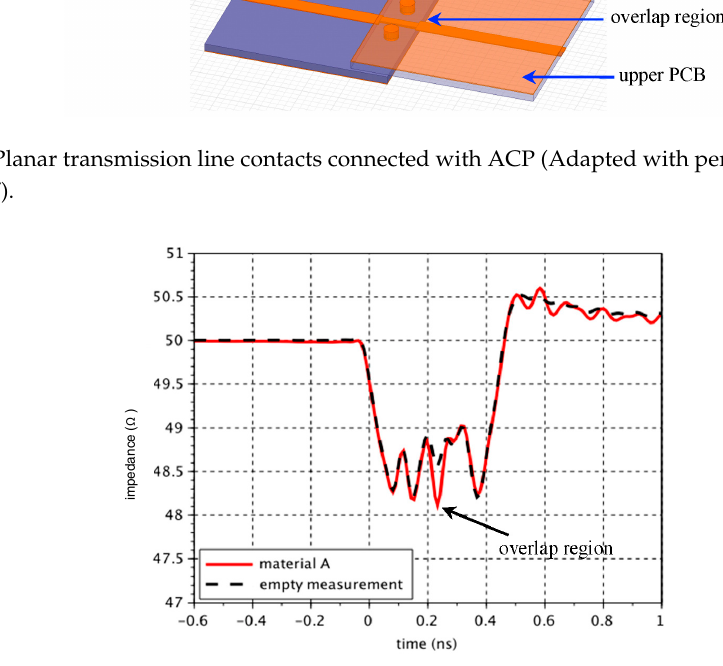
Figure 4. Impedance profiles of planar transmission line contacts (Adapted with permission from [6], IEEE, 2017).